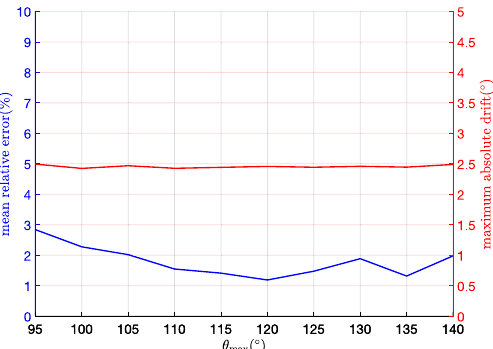
32 , θ lim M b for =